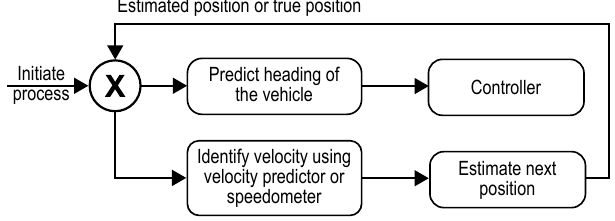
Figure 2. Handling cases of sensor failure.